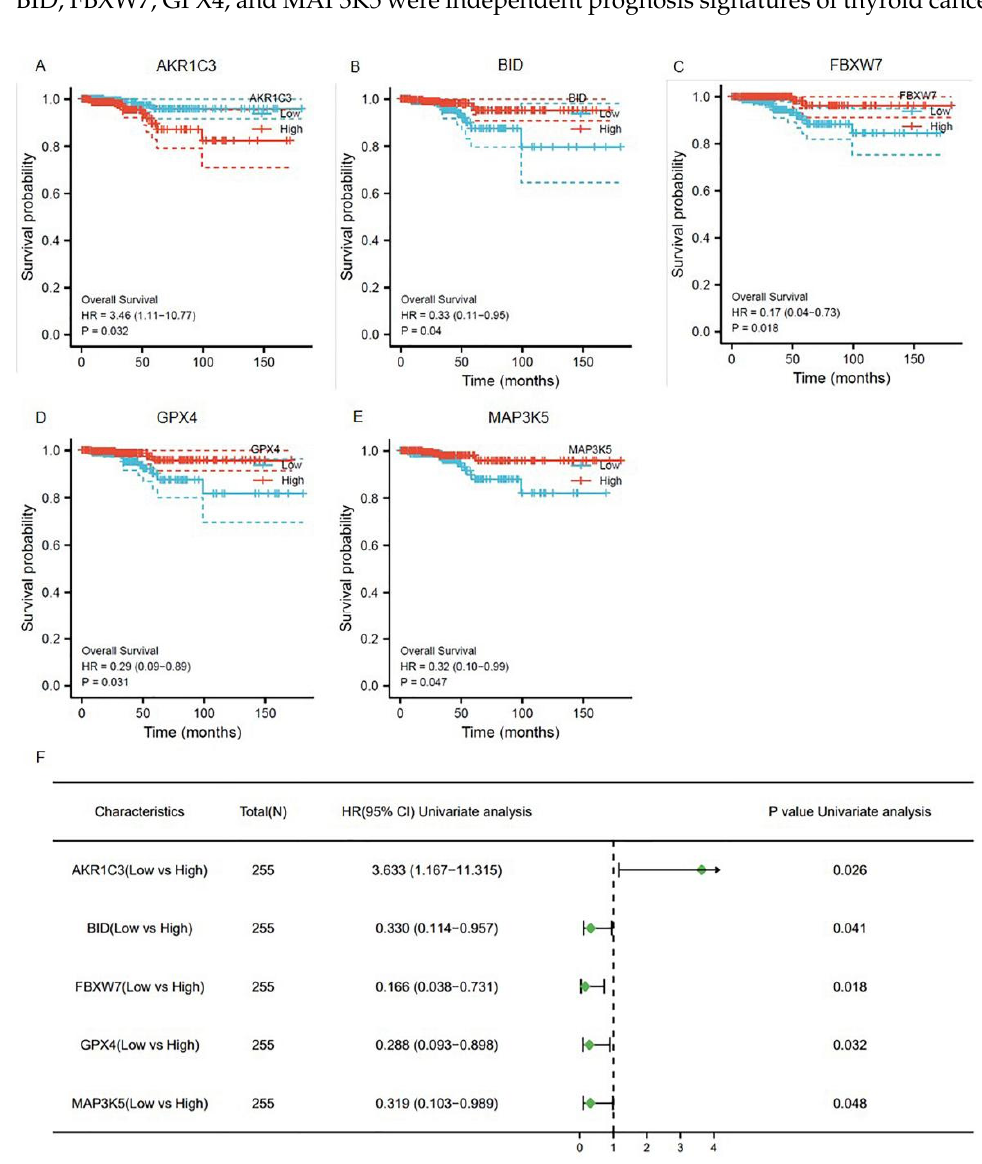
Figure 2. The prognostic ferroptosis signature was plotted using Kaplan–Meier plots and forests plots: ( A – E ) Kaplan–Meier plots showing the ferroptosis genes with prognostic values; ( F ) the forest plot showing the results of the univariate Cox regression analyses.